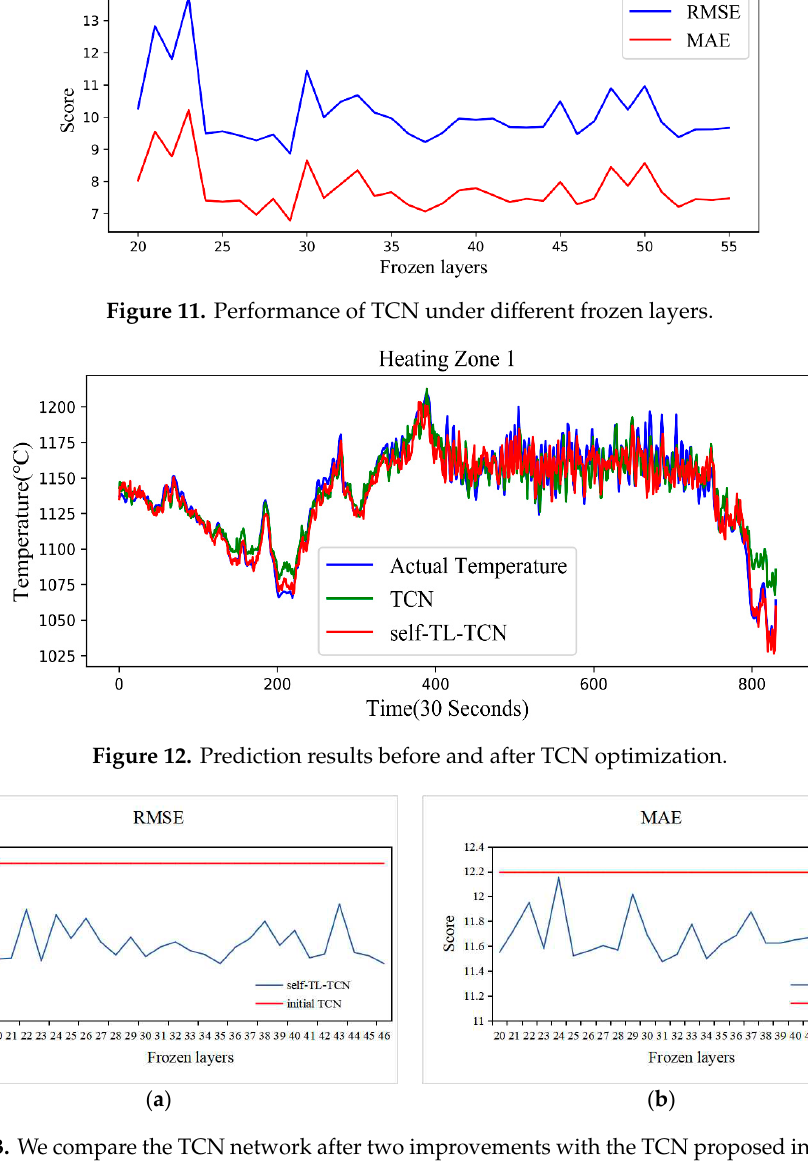
Figure 11. Performance of TCN under different frozen layers.